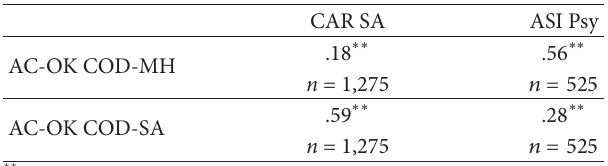
T 3: Correlations between AC-OK Co-occurring Screen and the reference